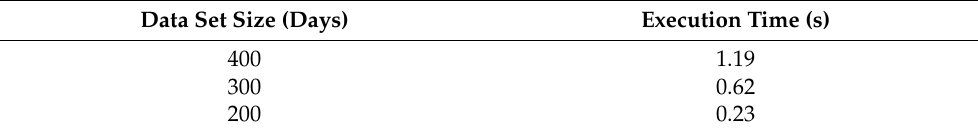
Table 7. Data size impact on clustering execution time.